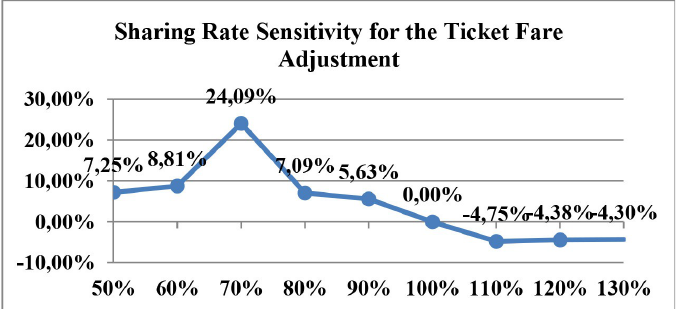
Figure 6. Sharing Rate Sensitivity Line Chart After Ticket Fare Adjustment